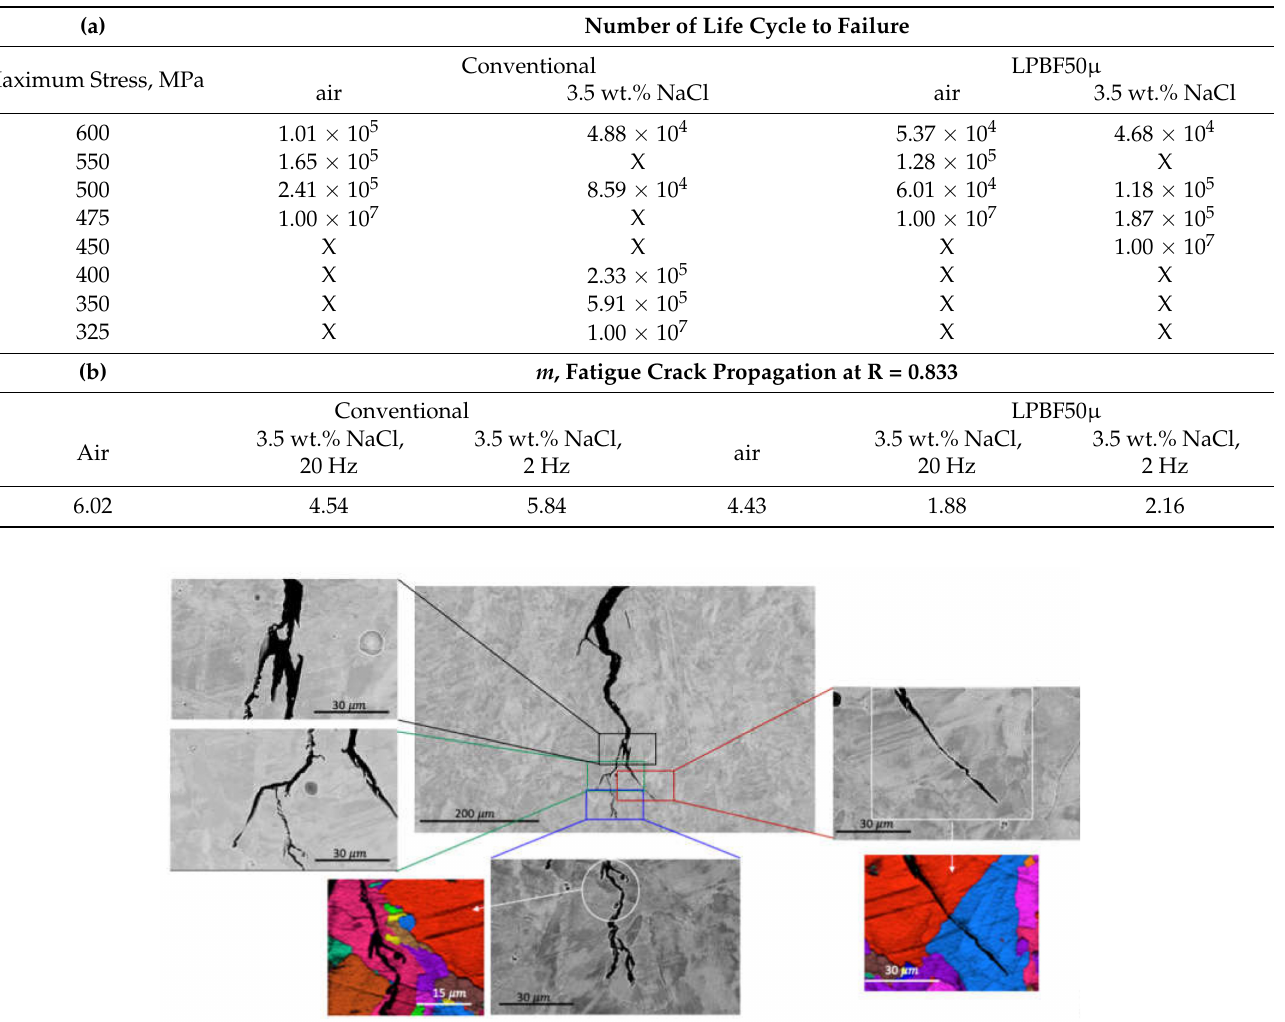
Table 4. Summary of the ( a ) HCF and ( b ) FCP results. For the HCF test, “X” represents that no test has been conducted for that condition. All the tests were stopped at the 10 7 cycle. If no failure occured, the endurance limit was assumed to be reached.